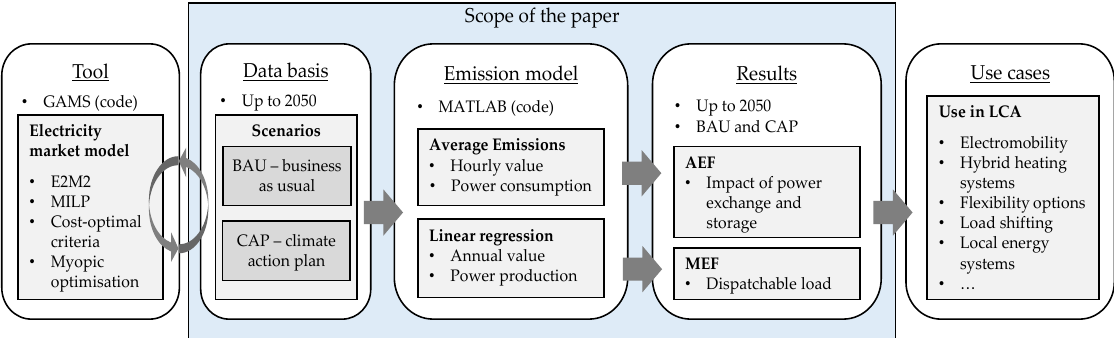
Figure 1. Setup and scope of the paper.